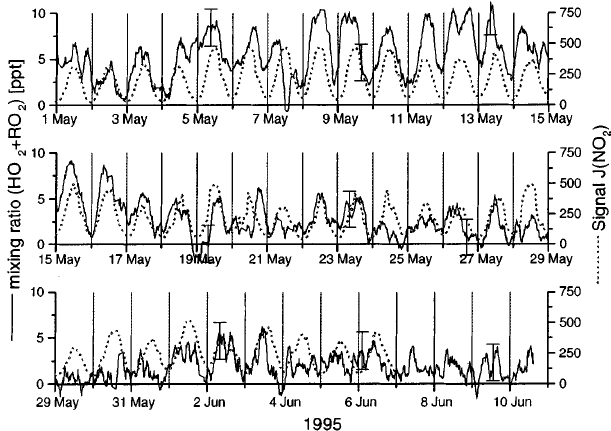
Fig. 4. ARCTOC 1995: all data of O 3 , BrO, NO 2 and SO 2 measured by DOAS during the campaign and temperature at Zeppelin station (ARCTOC, 1997)